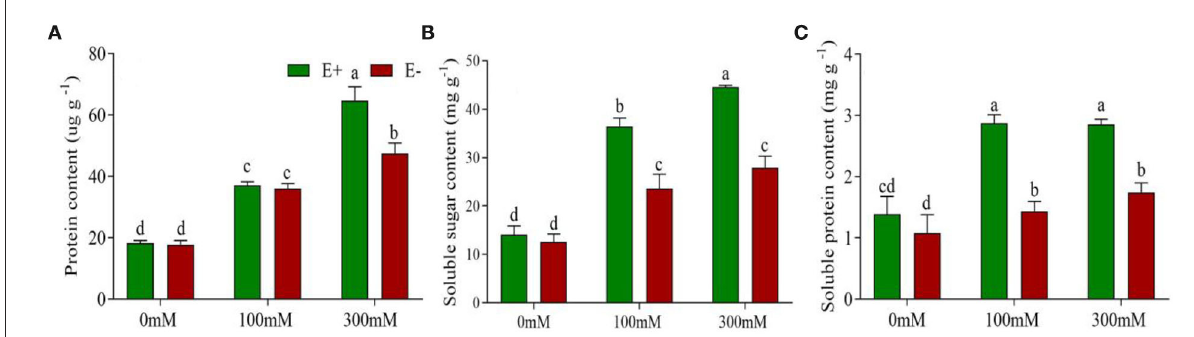
FIGURE3 Epichloë bromicola enhances barley osmotic adjustment capacity under salt stress conditions. Proline contents (A) , soluble sugar contents (B) , and soluble protein contents (C) of barley inoculated with E. bromicola and subjected to NaCl concentrations of 0, 100, and 300mM (values are means ± SE). Green bars represent E + barley, and red bars represent E– barley. Measurements were carried out after 21 days of plant growth under salt stress. Different letters indicate significance at a p -value < 0.05 among treatments (Tukey’s